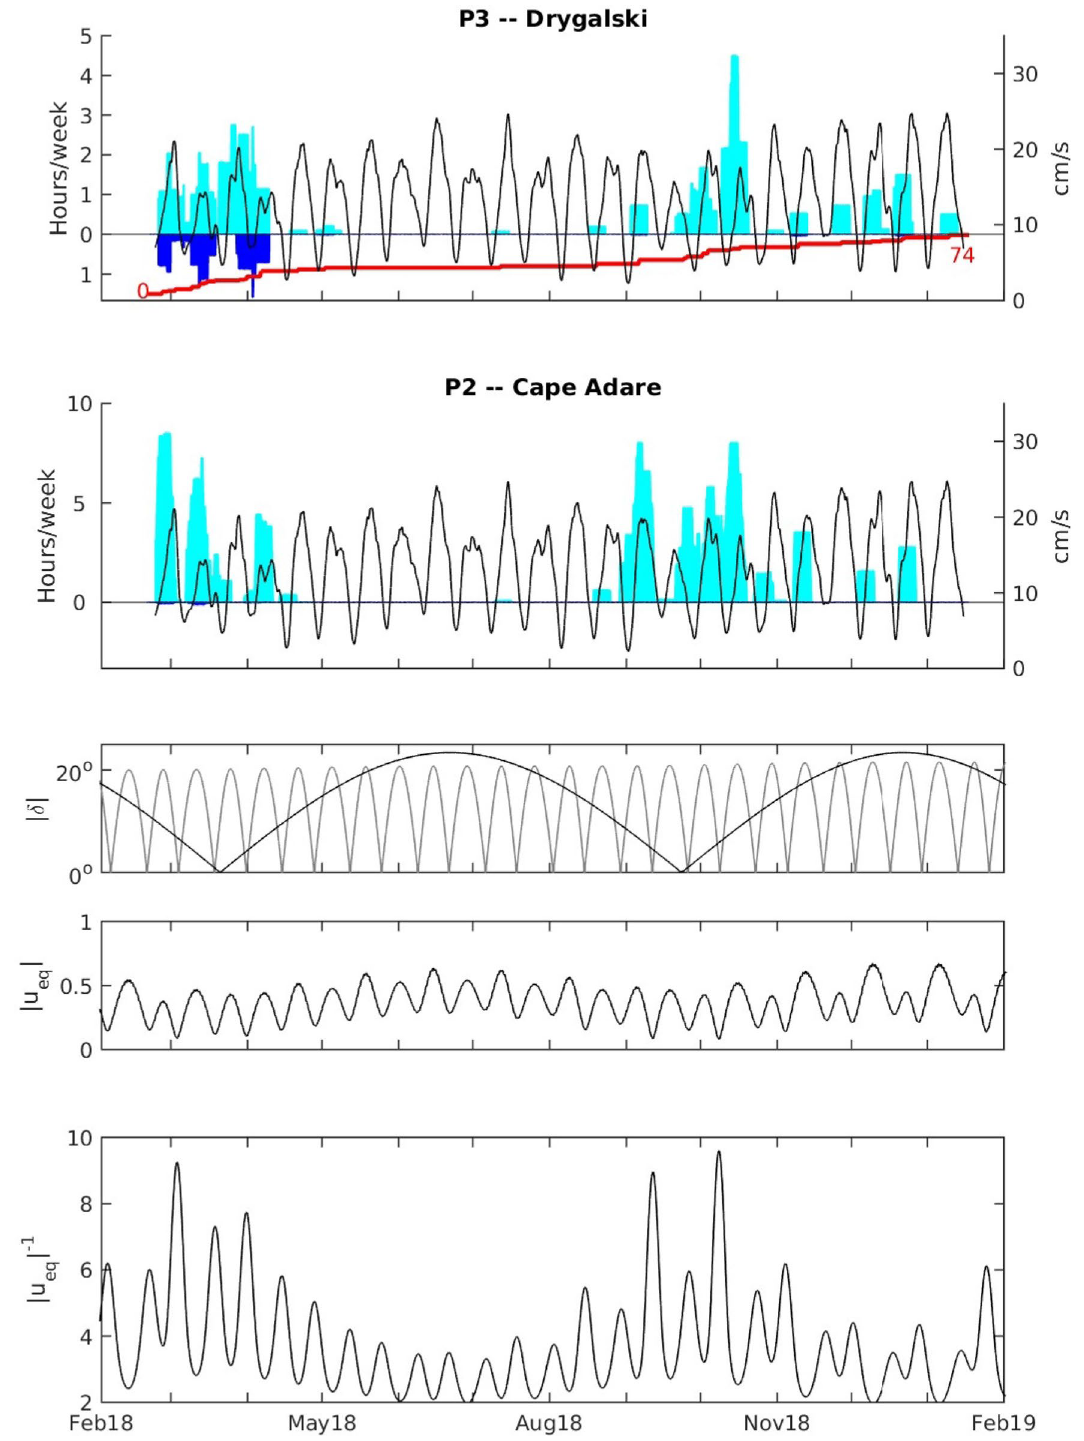
Figure 3. The top two panels show the hours per week that the lowest sensors on each mooring measured water colder than − 1 °C (light blue bars) and also saltier than 34.75 (blue bars pointing downward). The red line shows the cumulative total of plume events at P3 from 0 at the start of the record to 74 at the end. The speed of the tidal flow at 478 m above bottom at P3 averaged over 3 days (black lines) is superimposed over the time of cold water at both moorings. The lower three panels show the absolute value of the declination ( | δ | ) of the sun (black) and moon (gray), the magnitude of the equilibrium tidal velocity averaged over 3 days and the inverse (cid:31) (cid:31) − 1 averaged over a week ( (cid:31) (cid:31) u eq